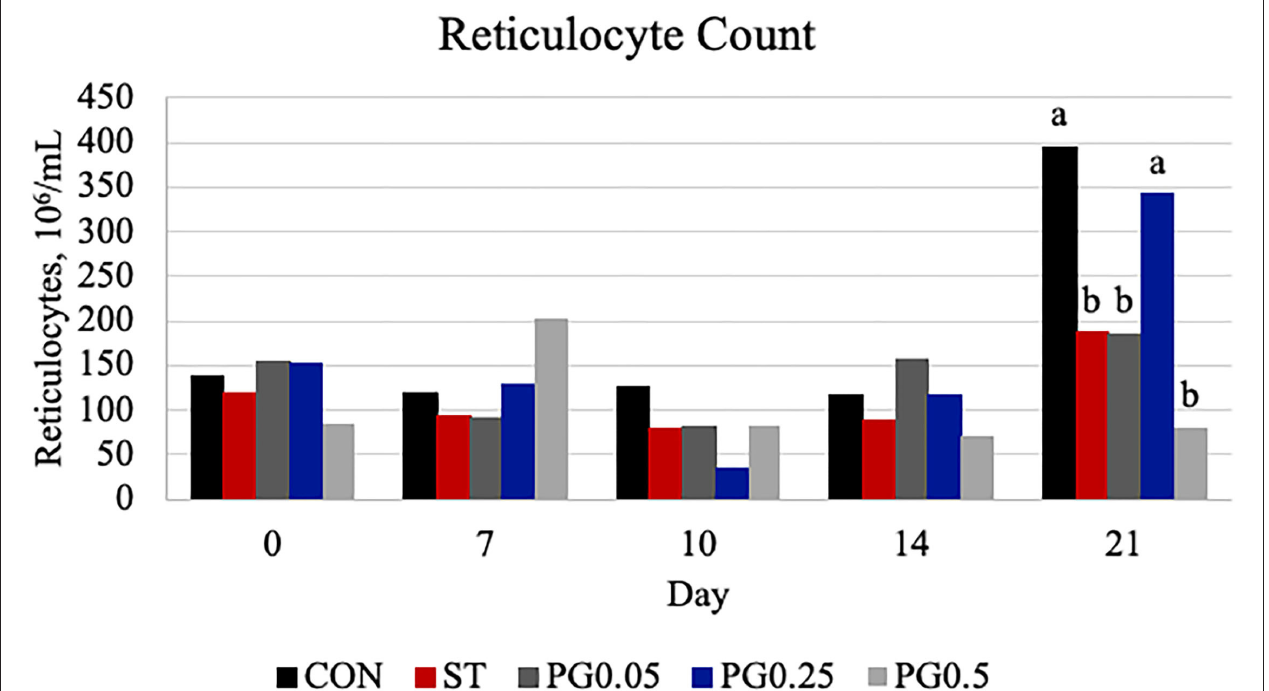
FIGURE 6 | Reticulocyte count was measured on days 0, 7, 10, 14, and 21. There was a tendency for a treatment × time interaction ( P = 0.1004). There was a treatment difference on day 21 ( P = 0.0013), where CON and PG0.25 were increased when compared to all other treatments ( P ≤ 0.0426). The largest SEM per time point is reported as 10 6 /ml and include 82.72, 90.69, 65.83, 57.46, and 87.72 for days 0, 7, 10, 14, and 21, respectively. Bars with different superscripts are statistically different ( P <